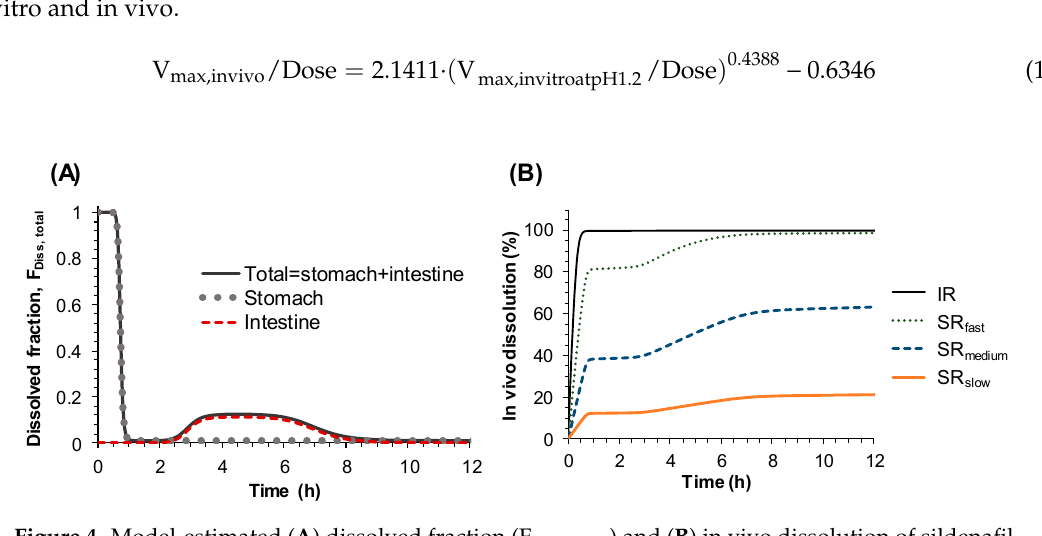
Figure 4. Model-estimated ( A ) dissolved fraction (F Diss, total ) and ( B ) in vivo dissolution of sildenafil (%) from IR and SR tablets.